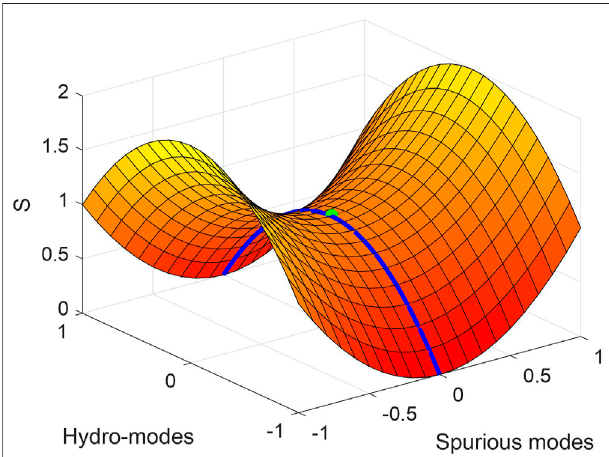
FIGURE 2 | Sketch of the entropy S along the modes of a generic fi rst- order theory (arbitrary units). The green saddle point is the equilibrium state (i.e. the homogeneous perfect fl uid state) of a generic Navier – Stokes – Fourier model,thebluelinemarksthestatesaccessiblebytheNewtonianlimitof the model. Along the Hydro-modes the entropy decreases: these modes are dampedifweimposethevalidityofthesecondlaw.Alongthespuriousmodes theentropygrows:thesecondlawforcesthemtogrowinde fi nitely,originating the instability.